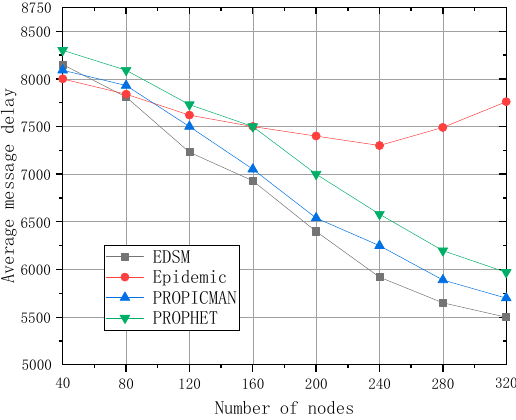
Figure 5. Average message delay under a different number of nodes.